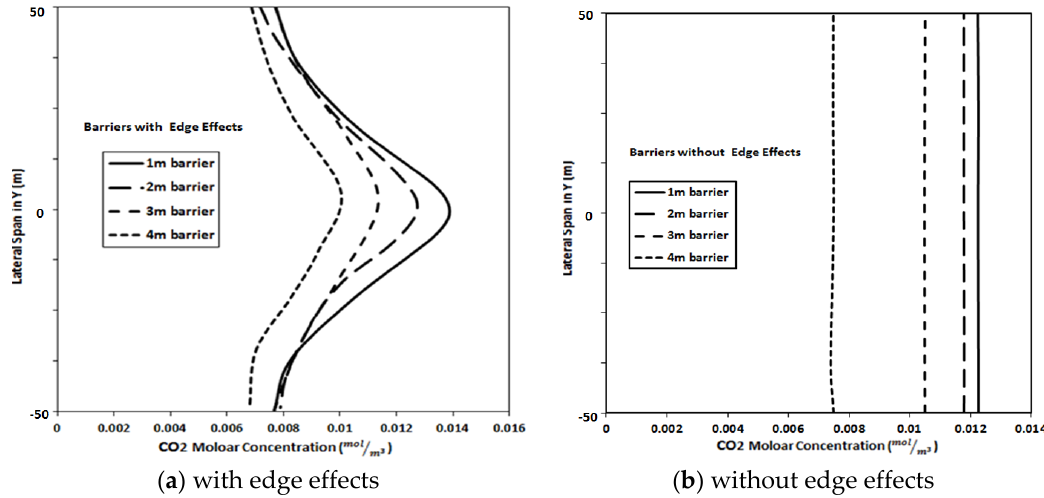
Figure 14. CO 2 concentration profile at downwind X = 100 m.